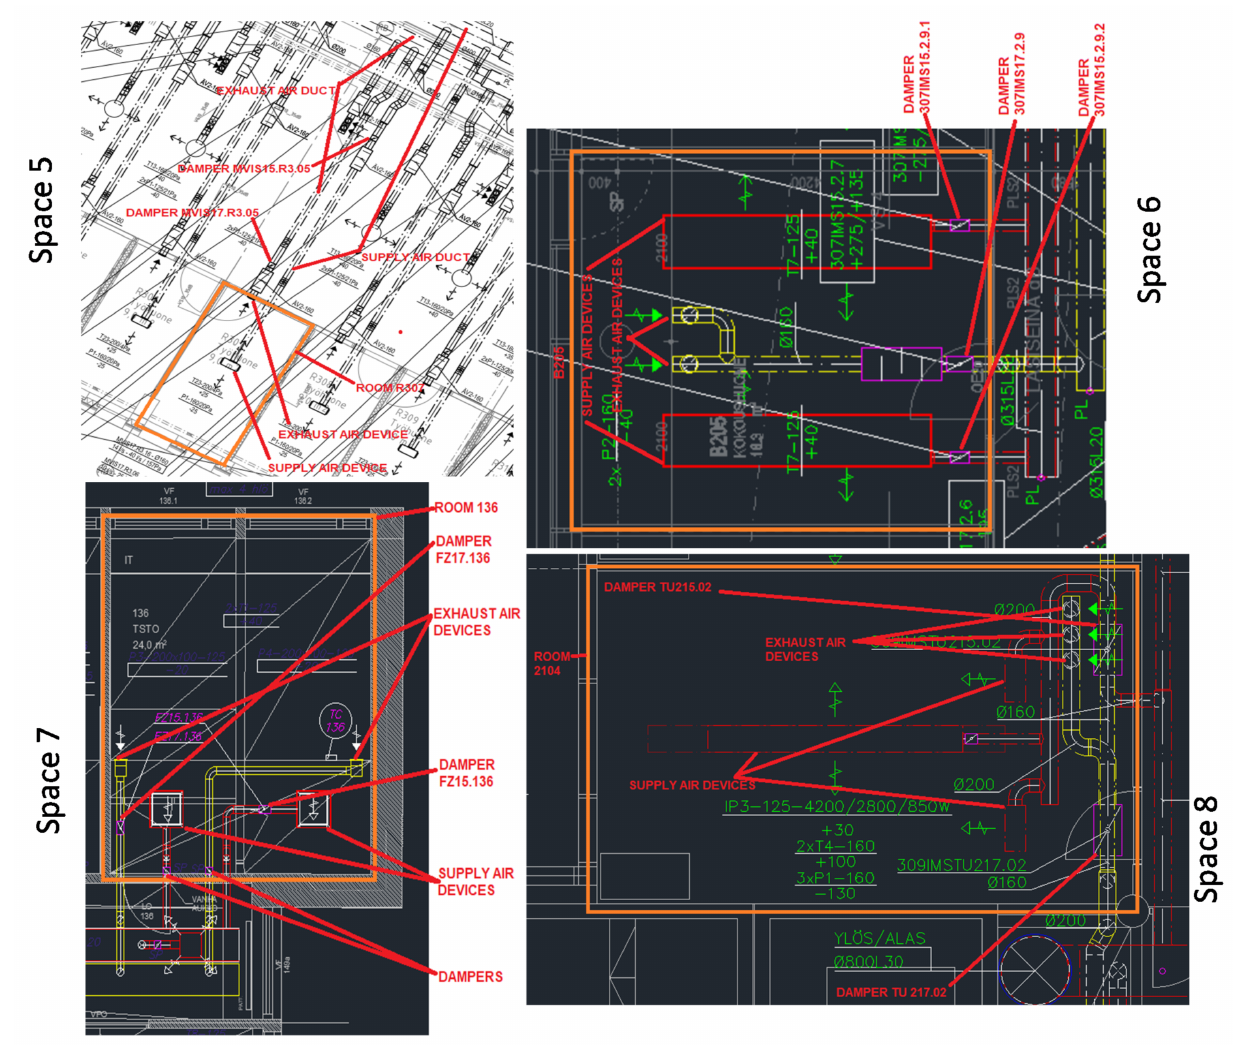
Figure 2. The drawing of ventilation systems in Spaces